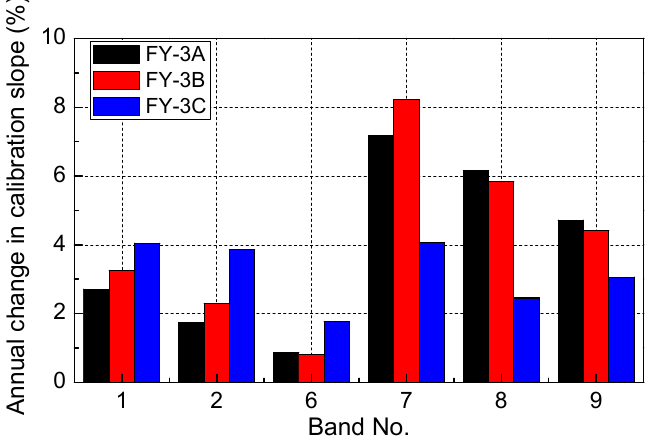
Figure 8. Annual change in the calibration slope derived by using the multisite (MST) calibration method for the FY-3A, FY-3B, and FY-3C VIRR. Table 2. Linear fit parameters for the normalized calibration coefficients of the FY-3A, FY-3B, and FY-3C VIRR.